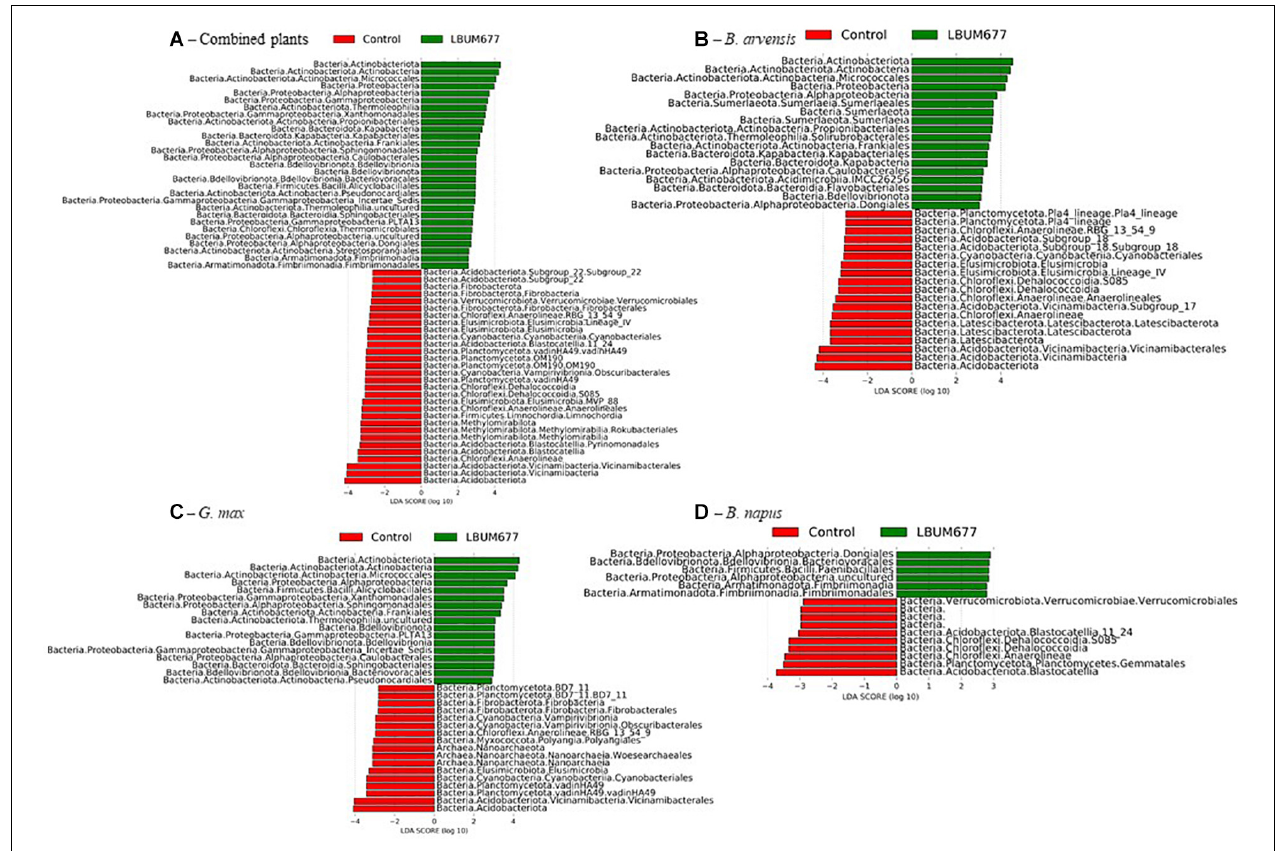
FIGURE 8 | Histogram of the LDA scores computed for differentially abundant taxa between control samples and LBUM677-treated samples as determined using LEfSe. (A) the combination of all three plant species, (B) B. arvensis plants, (C) G. max plants, and (D) B. napus plants. Red indicates an increased abundance in control samples while green indicates an increase in LBUM677-treated samples. Differentially abundant sequences were determined using the non-parametric factorial Kruskal-Wallis sum-rank test. A subsequent Linear Discriminant Analysis was used to estimate the effect size of each differentially abundant